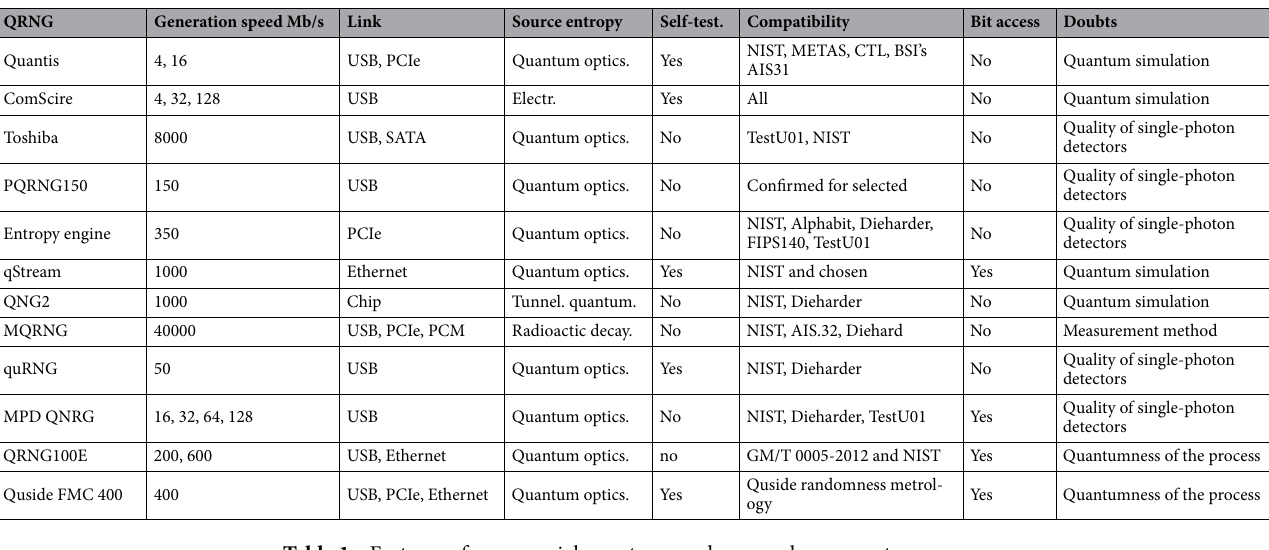
Table 1. Features of commercial quantum random number generators.